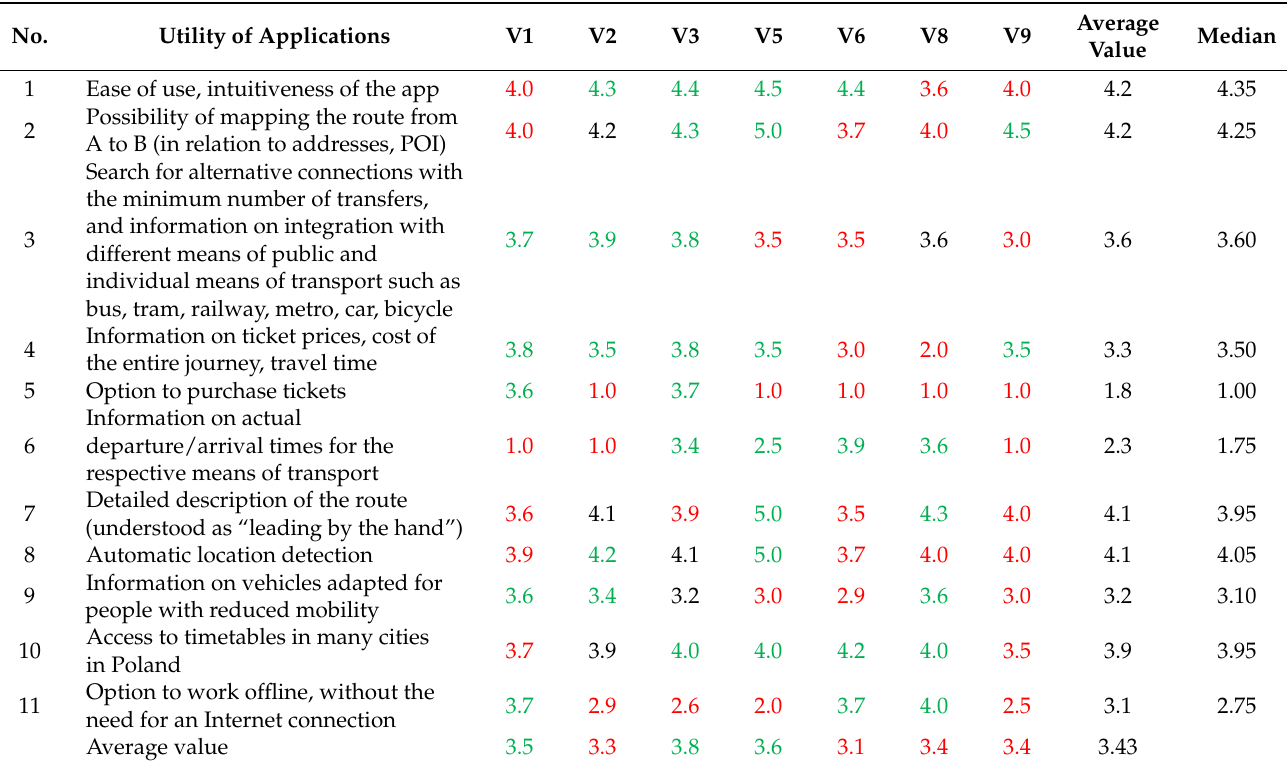
Table 3. Average scores for individual travel